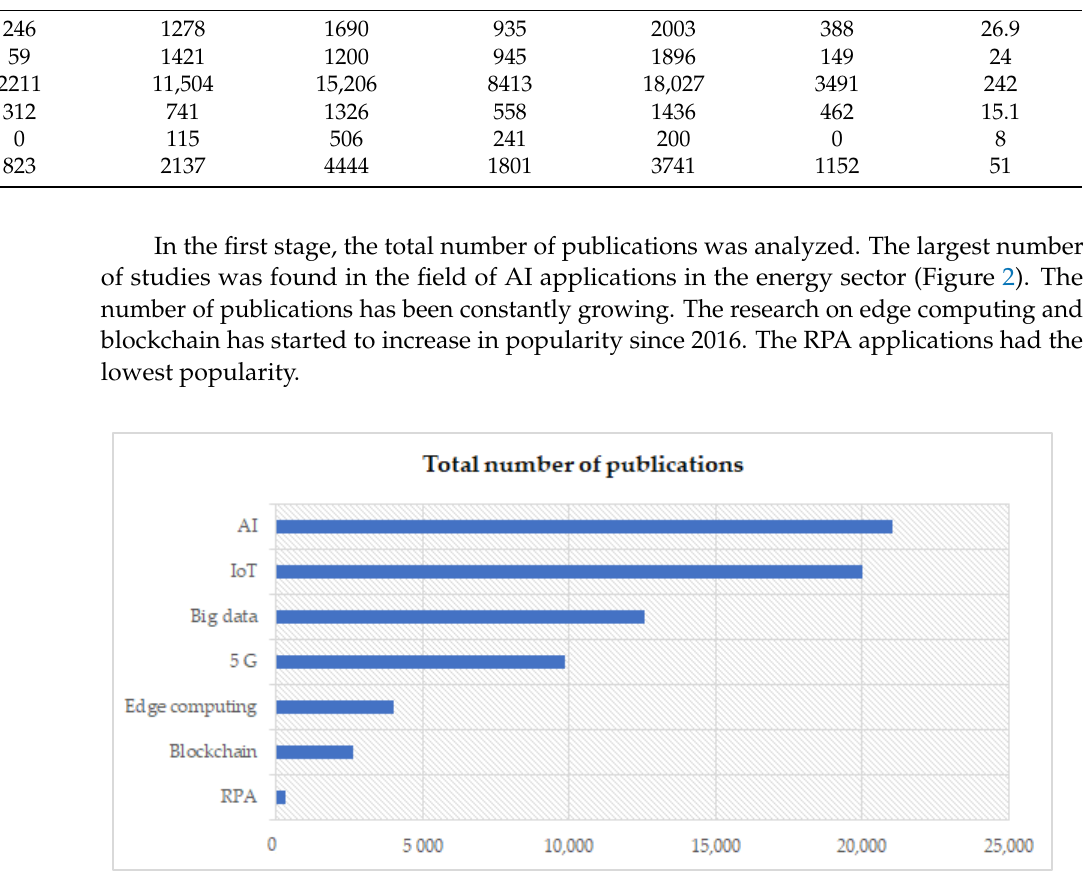
Table 2. The descriptive statistics of publication number on cognitive technologies.